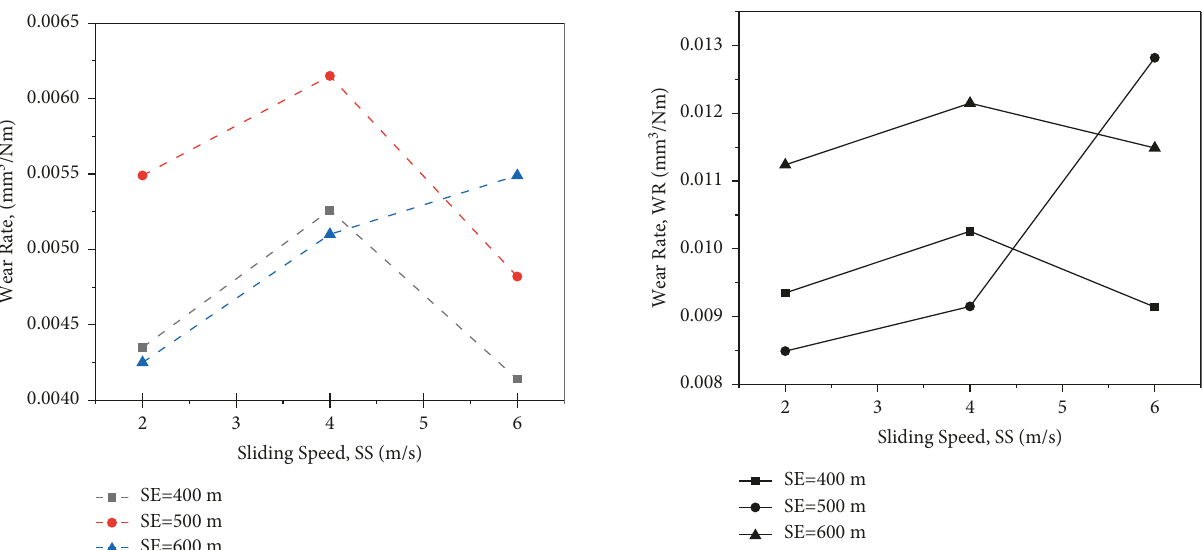
Figure 3: Interaction between SS and SE levels at LD � 30N.